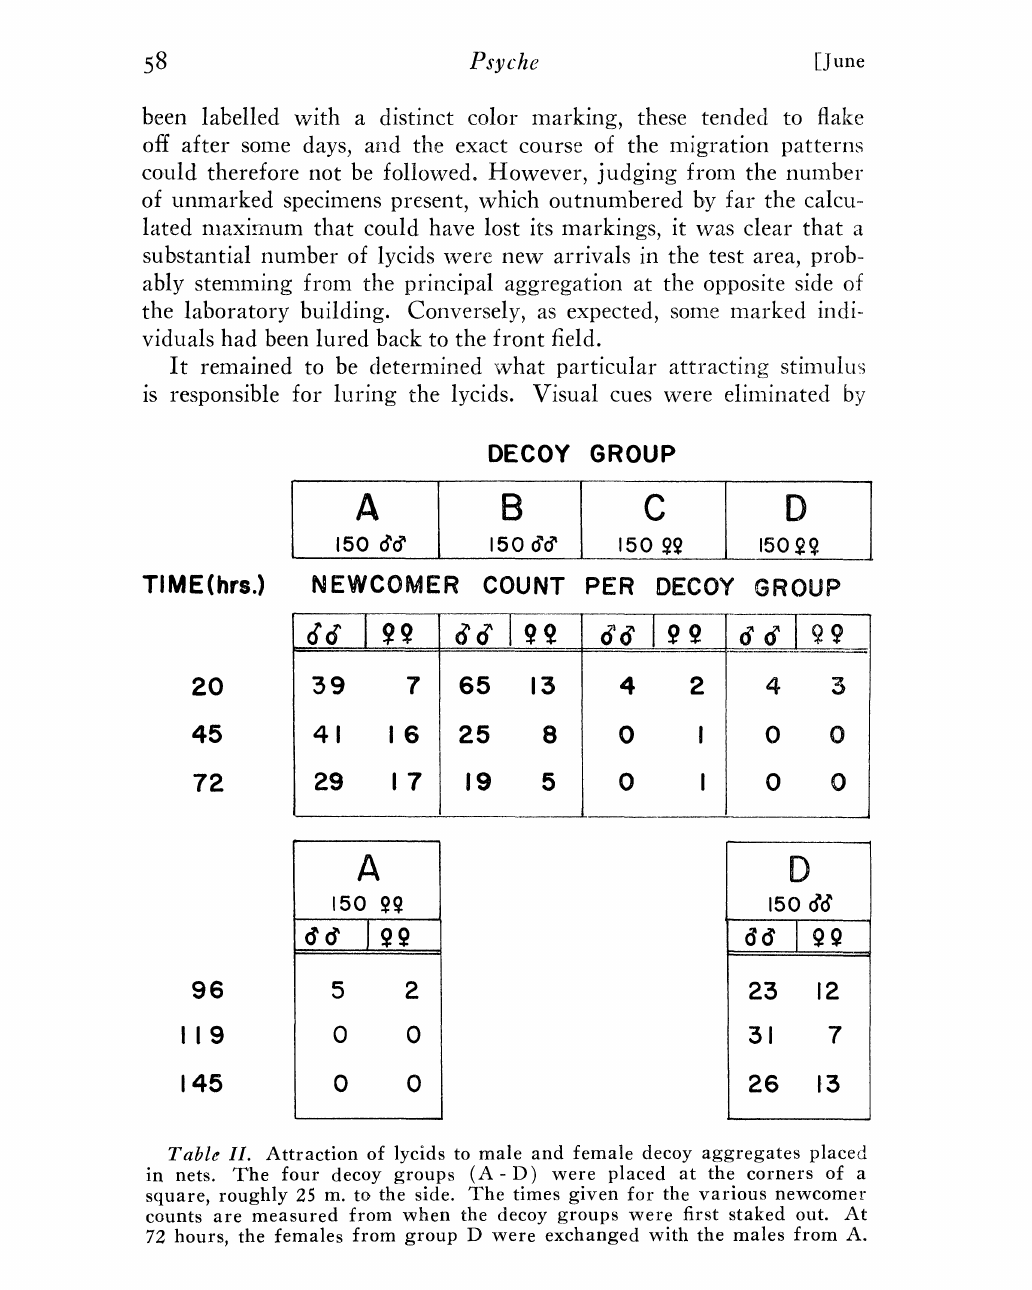
Table II. Attraction of lycids to male and female decoy aggregates placed in nets. The four decoy groups (A-D) were placed at the corners of a square, roughly 25 m. to the side. The times given for the various newcomer counts are measured from when the decoy groups were first staked out. At 72 hours, the females from group D were exchanged with the males from